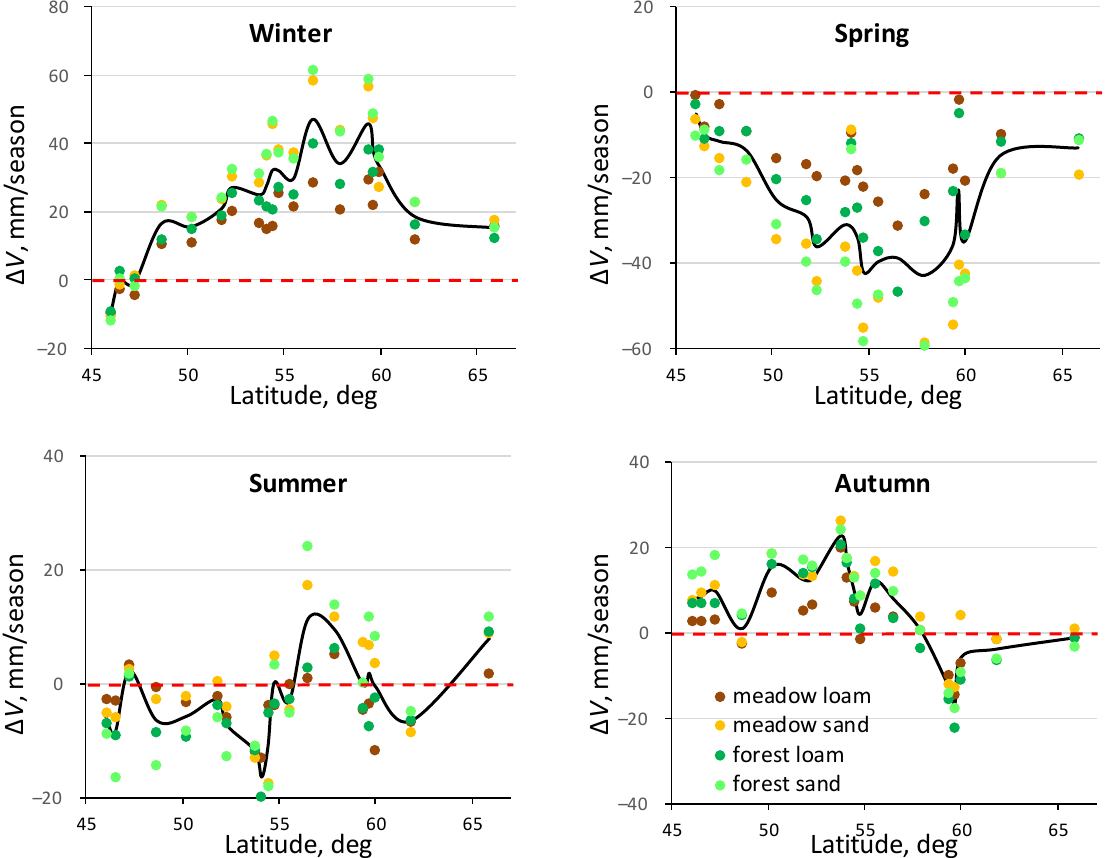
Figure 13. Latitudinal changes in average seasonal soil water storage ∆ V in modern period. Black line - average for different landscapes.